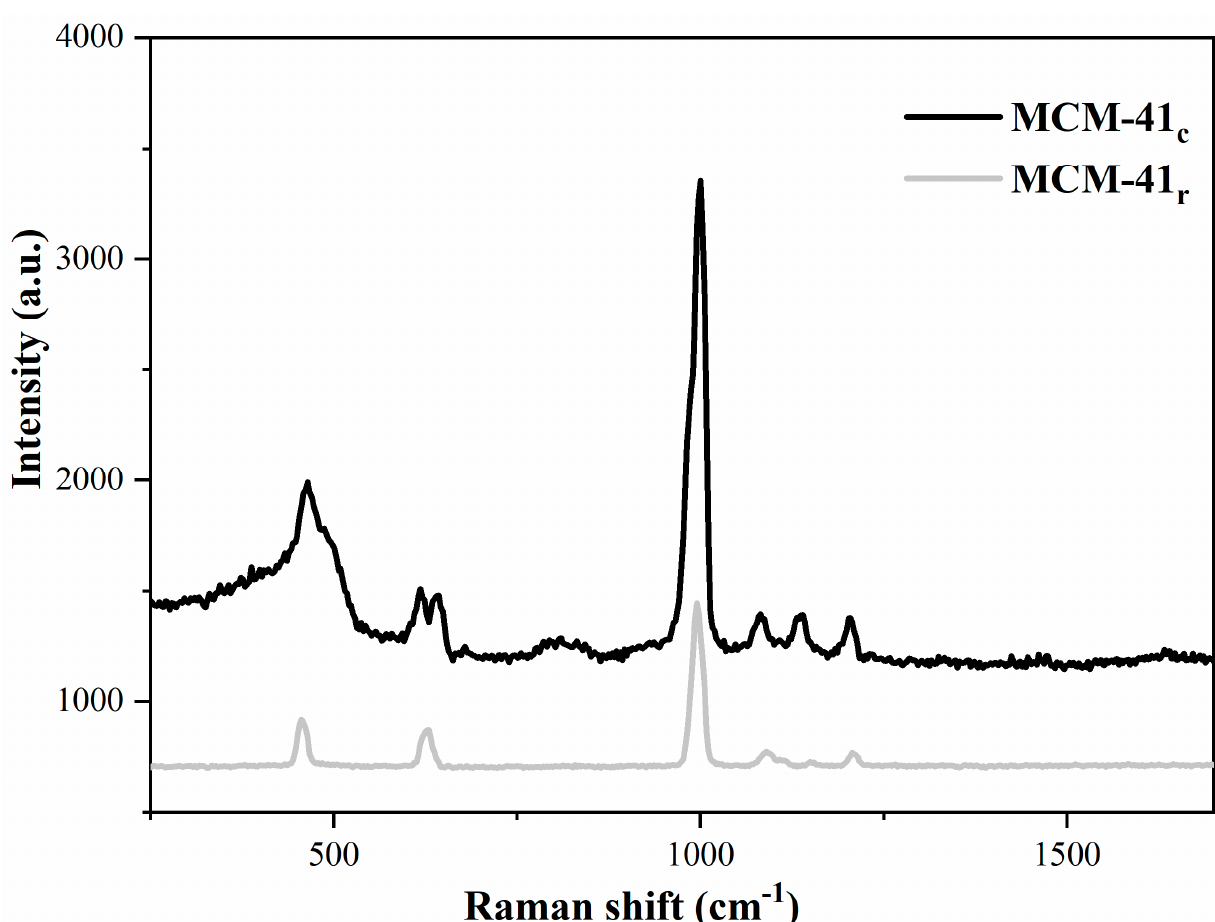
Figure 9. Raman spectra of MCM-41 r and MCM-41 c .